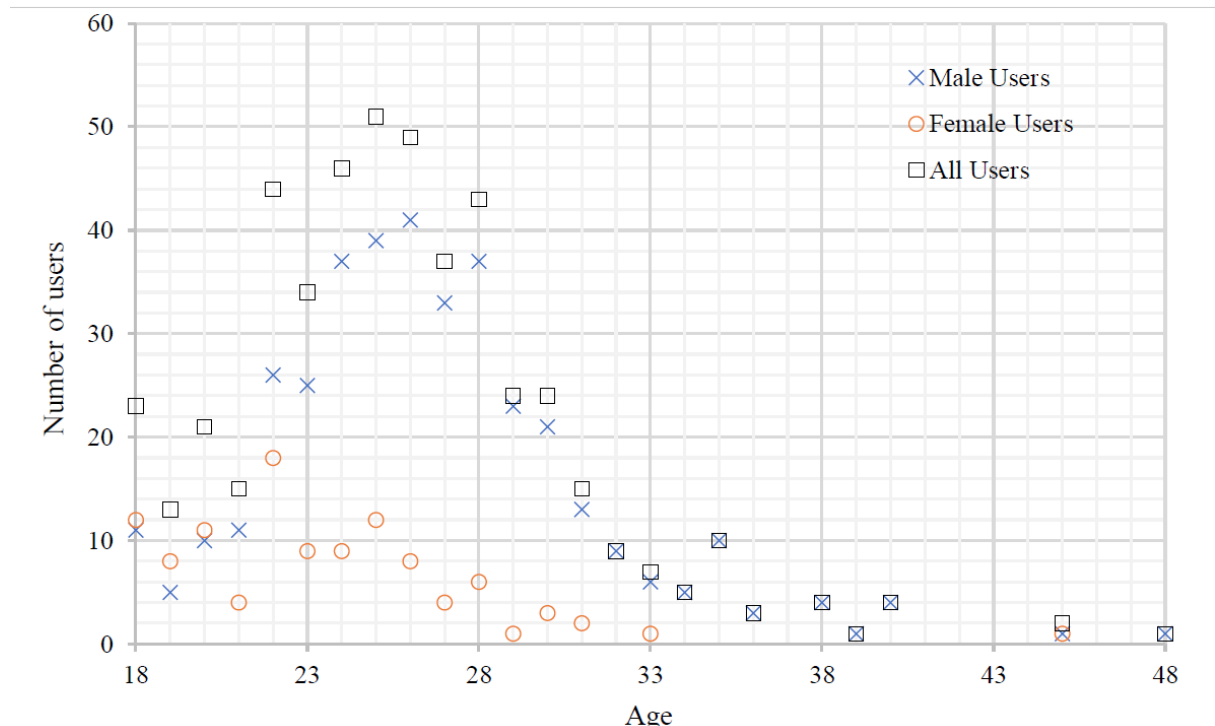
Figure 4. Distribution of user age in sexual behavior acquisition system